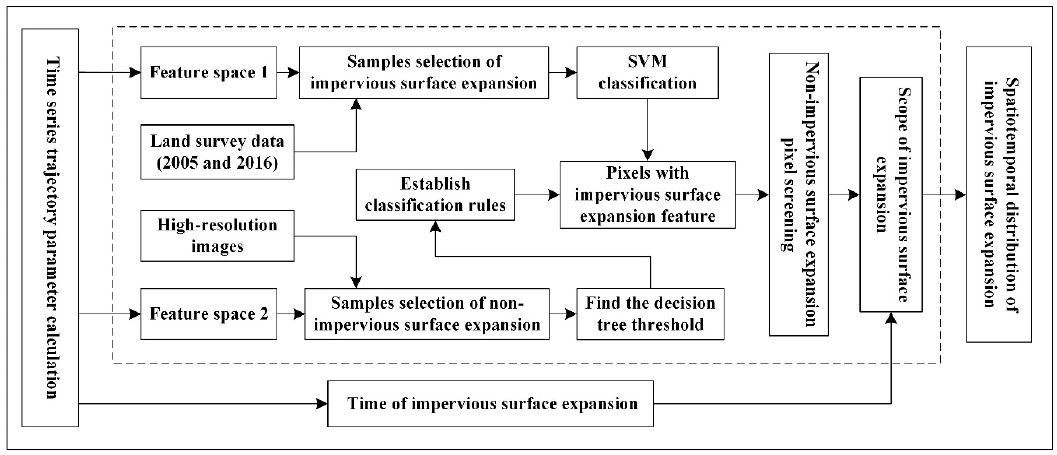
Figure 5. Multi-level classification for time series trajectories.